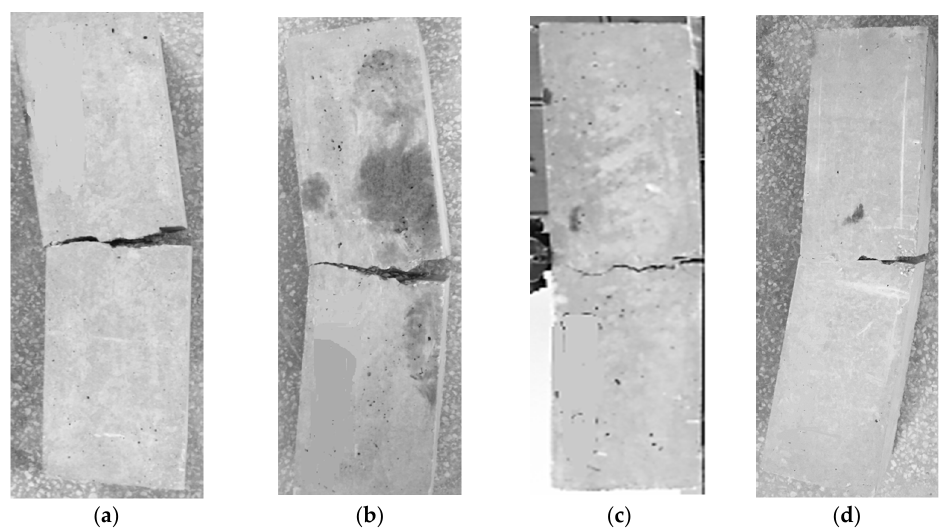
Figure 13. Failure in specimens due to flexure stress in case of: ( a ) without RTA and PF; ( b ) without PF and with 20% RTA; ( c ) with 2% PF and without RTA and; ( d ) with 2% PF and 20% RTA.